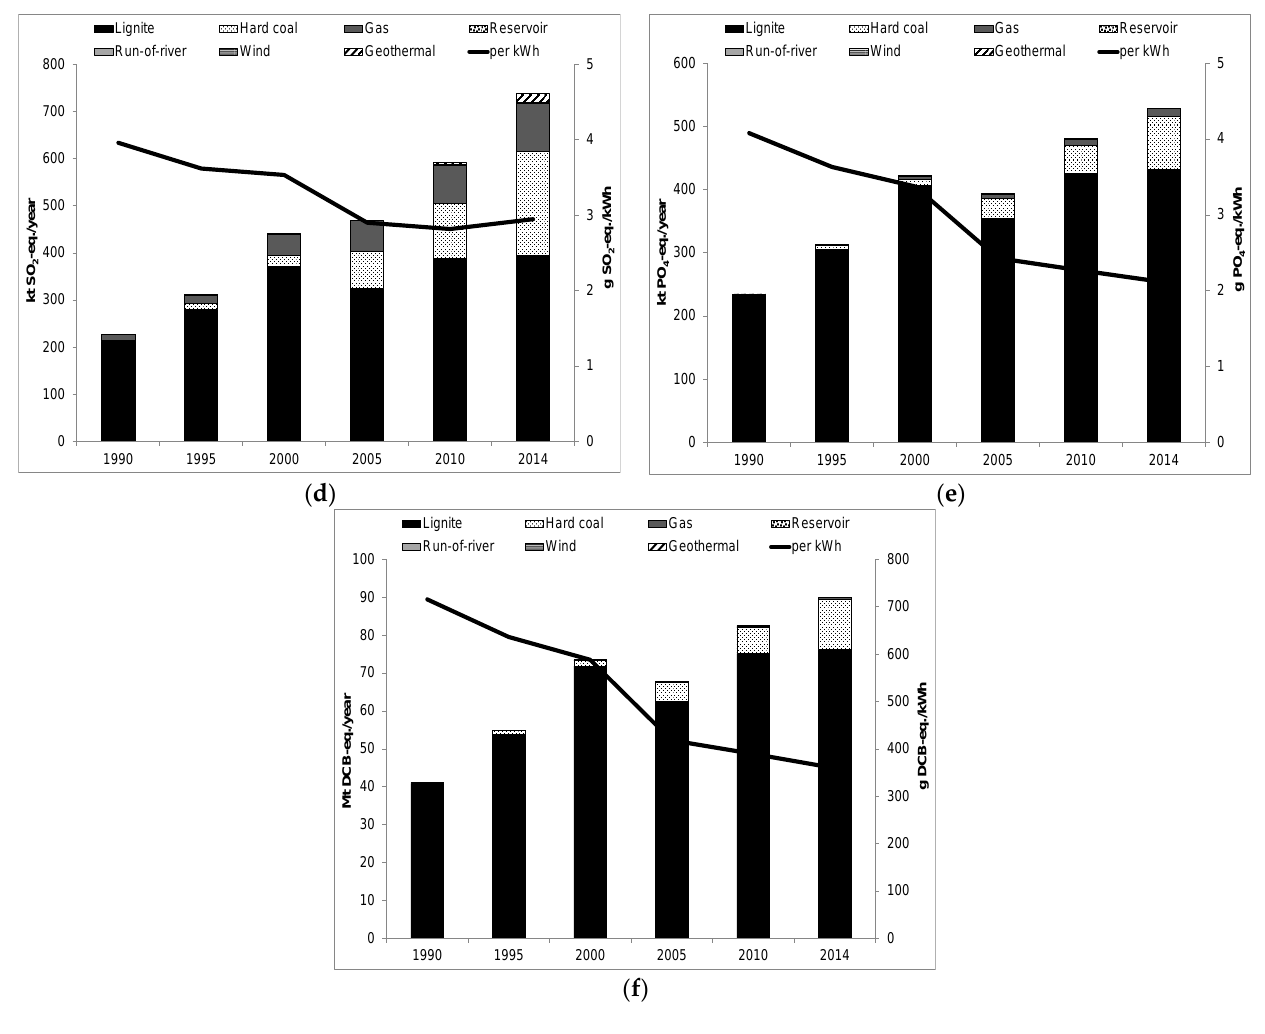
Figure 9. Cont. Figure 9.